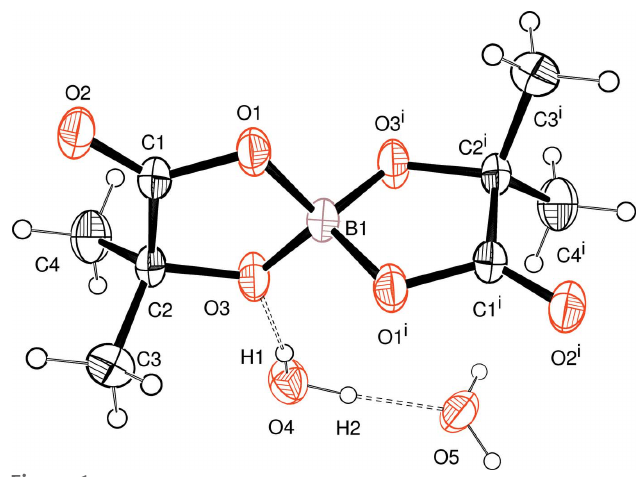
Figure 1 A view of the asymmetric unit of the title compound showing the atom numbering with displacement ellipsoids drawn at the 30% probability level. Symmetry code: (i) (cid:5) x + 1, (cid:5) y + 1, z